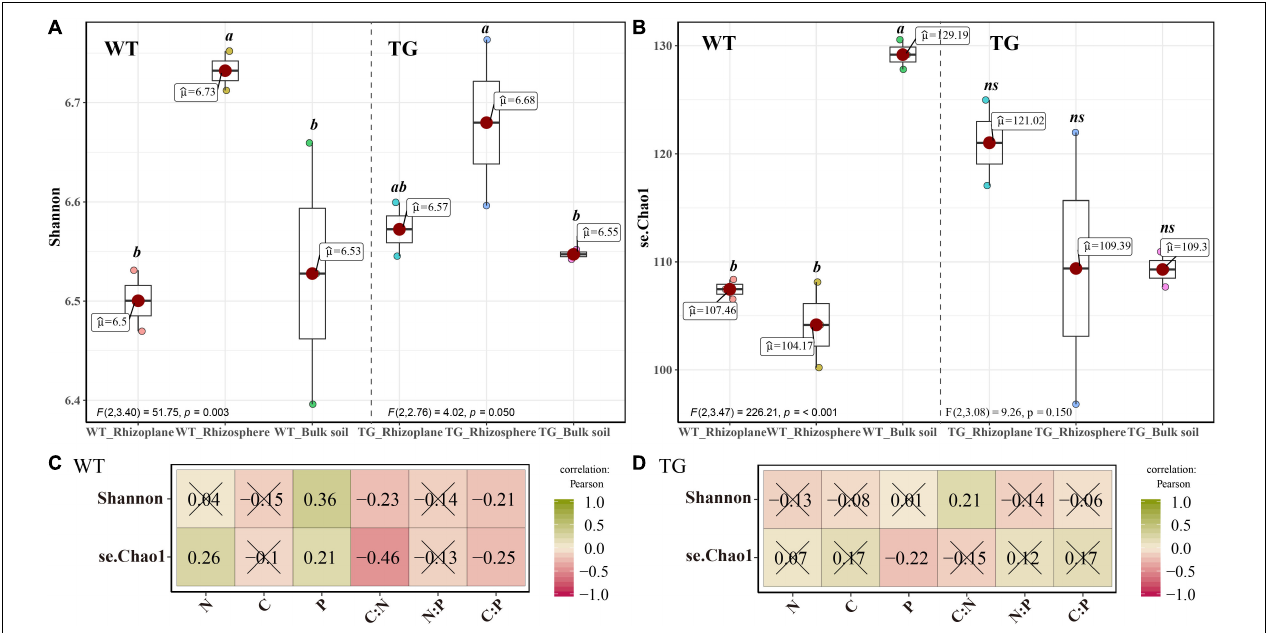
FIGURE 1 | (A,B) Bacterial alpha-diversity measurements of represented by Chao 1 Richness and Shannon Diversity in each area and cultivar. (C,D) The correlation between bacterial alpha-diversity and environmental factors using Pearson analysis.